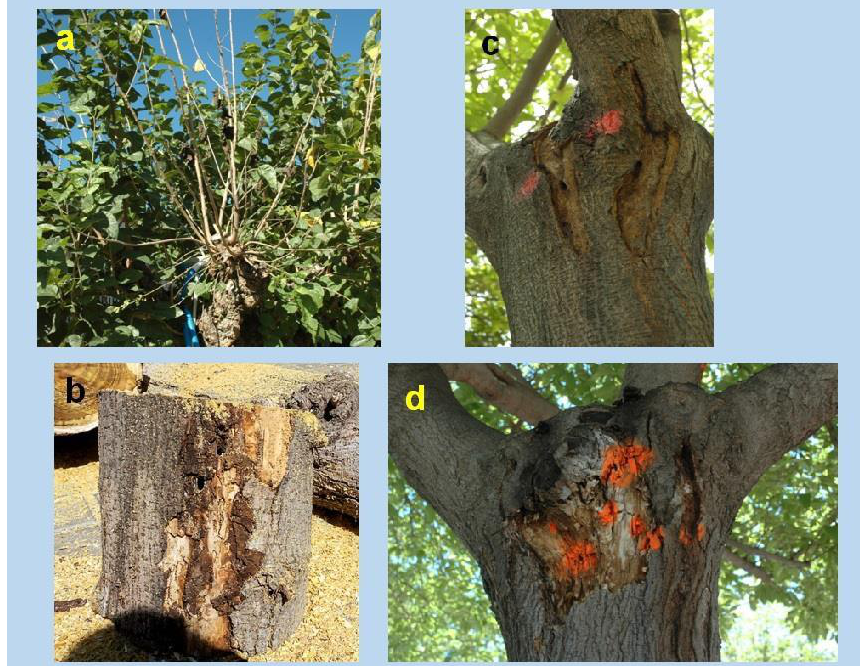
Figure 9. Damage to mulberries by X. chinensis larvae: ( a ) Loss of leaves in one of the main branches (trunk stump) of a mulberry tree due to phloem sap stoppage originated by X. chinensis larval damage at the stump base. ( b ) Slice of mulberry trunk with detached periderm showing consumed and dead phloem, as well as the remains of masses of packed frass and some adult emergence holes. ( c ) Similar to ( b ) but at the base of a main branch, frass already gone. ( d ) Exposed xylem sapwood beginning to dry and crack after heavy damage by X. chinensis larvae. ( a , c , d : photos V. Sarto i Monteys; b : photo G. Torras).